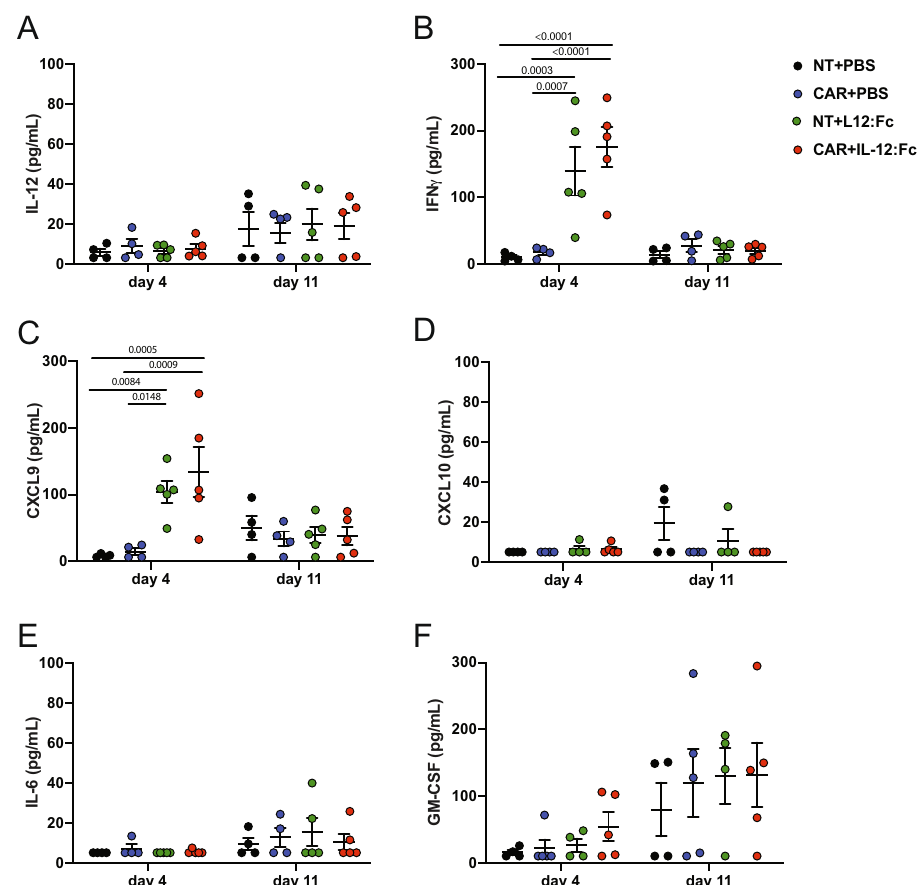
Fig. 5 Local administration of IL-12:Fc results in minimal systemic effects. Serum cytokines and chemokines were measured by cytokine bead array (CBA, Legendplex) at day 4 and 11 post IL-12:Fc administration. A IL-12, B IFN- γ , C CXCL9, D CXCL10, E IL-6, and F GM-CSF (NT + PBS n = 4, NT + IL-12:Fc n = 5, CAR + PBS n = 4, CAR + IL-12:Fc n = 5 mice from one experiment). Plots show mean ± SEM. Ordinary Two-way Anova with Tukey ’ s multiple comparison test. Source data are provided as a Source Data fi